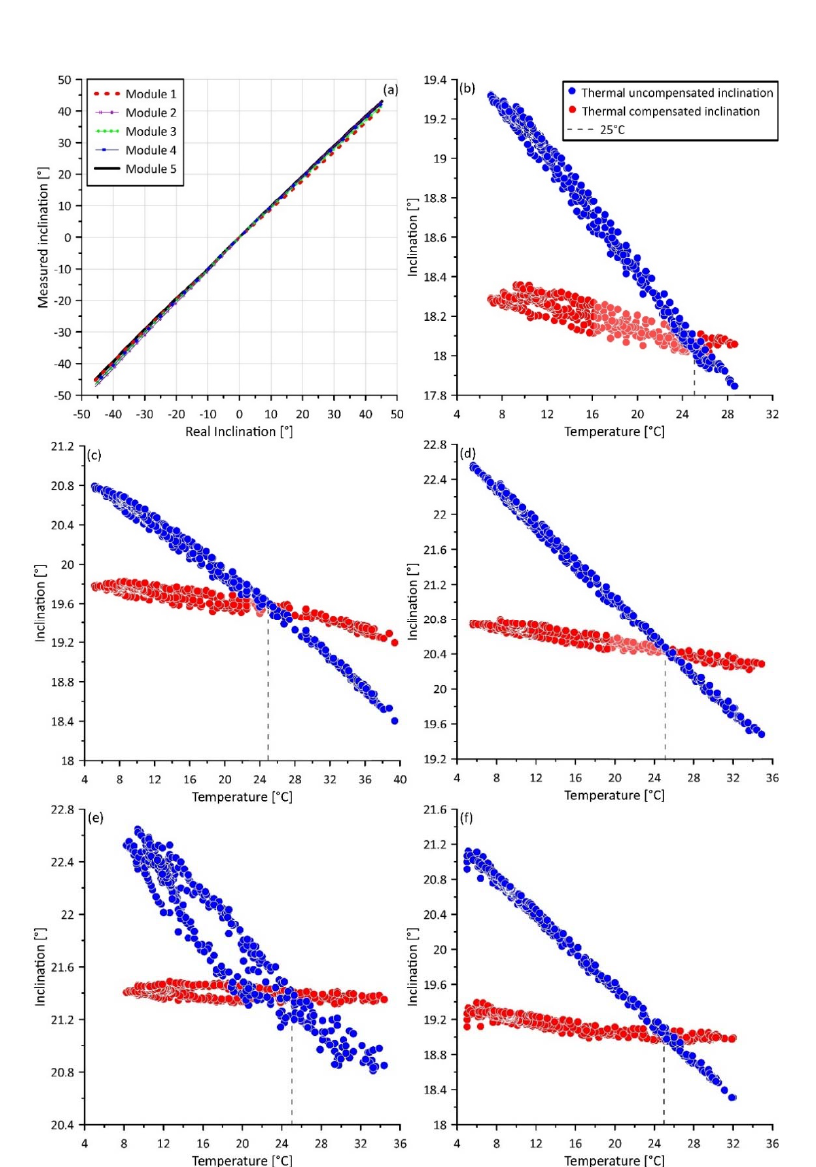
Figure 11. Graphs showing results of the thermal efficiency, linearity, and offset tests. Graph ( a ) shows results of linearity and offset tests. Graphs ( b – f ) present data derived by the thermal efficiency test of modules 1, 2, 3, 4, and 5, respectively. Table 2. RMSE calculated on the basis of data acquired in natural, uncontrolled temperature variation conditions in the range between 5 and 40 °C. The table provides both RMSE derived by thermally compensated and uncompensated measurements and variation of the RMSE after compensation.